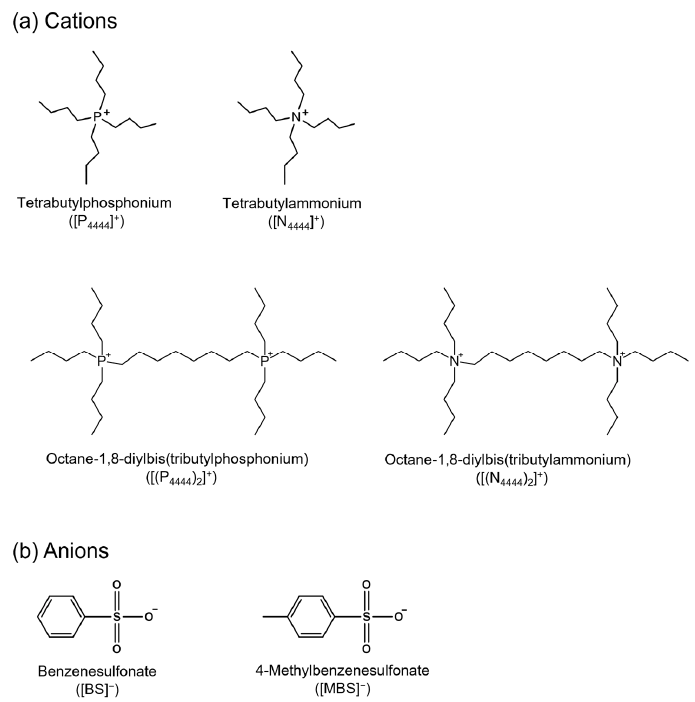
Figure 1. Chemical structures of ( a ) cations and ( b ) anions of the ionic liquid used in this study.